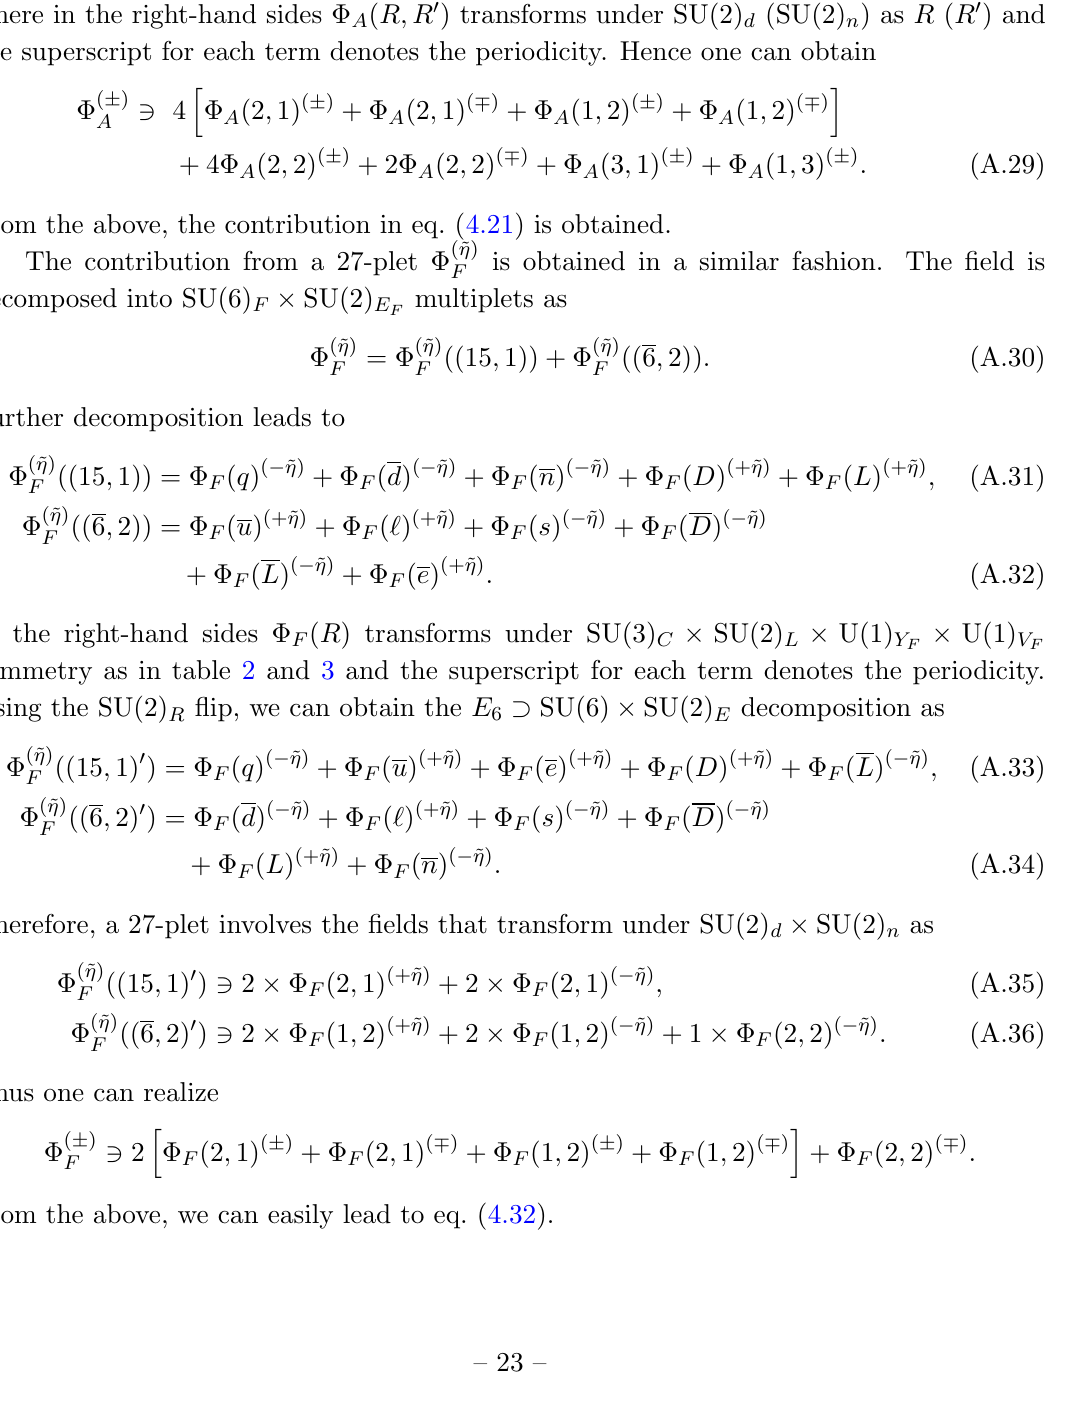
Table 3 . Representations and charges under SU(3) C , SU(2) L , U(1) Y where in the right-hand sides (cid:8)